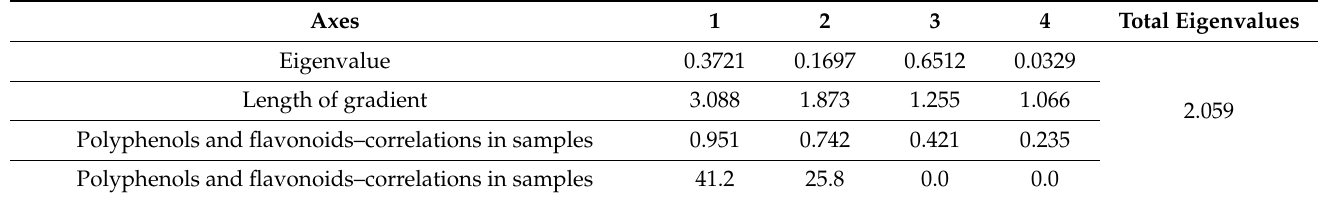
Table 7. Variance explained by the first four DCA axes (Figure 4).